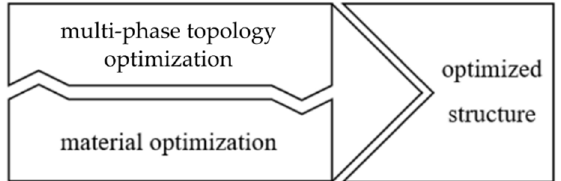
Figure 8. This method of simultaneous multi-phase topology and material optimization considers the most important properties of the materials used in the hybrid structures under consideration. The stiffness of the sFRP is considered by a multiphase BESO (see 6) and the anisotropy of the cFRP by the fiber angle optimization, which is performed in each iteration of the entire optimization.